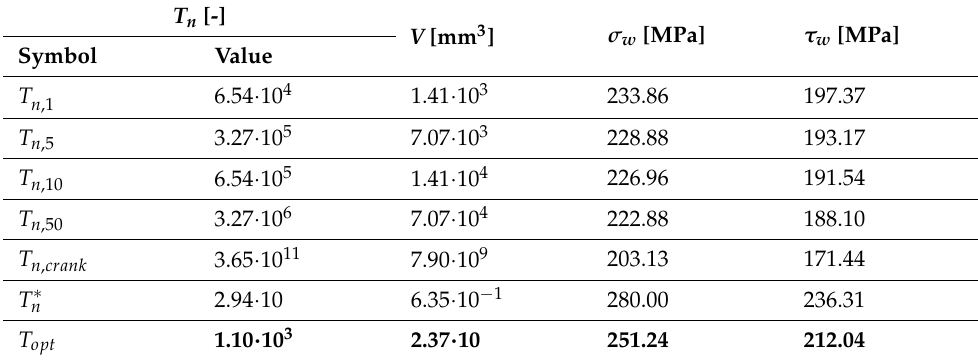
Table 5. Return period, prediction volume and fatigue limits for EN-GJS-700-2 DCI. T n